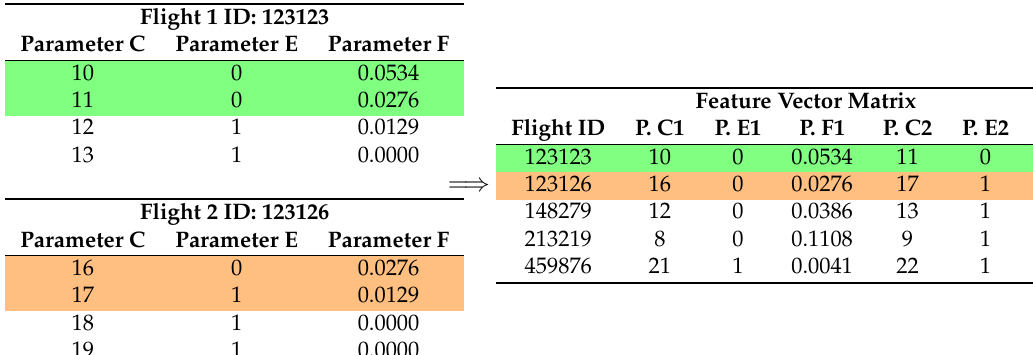
Table 7. Notional feature vector matrix assembly for multiple